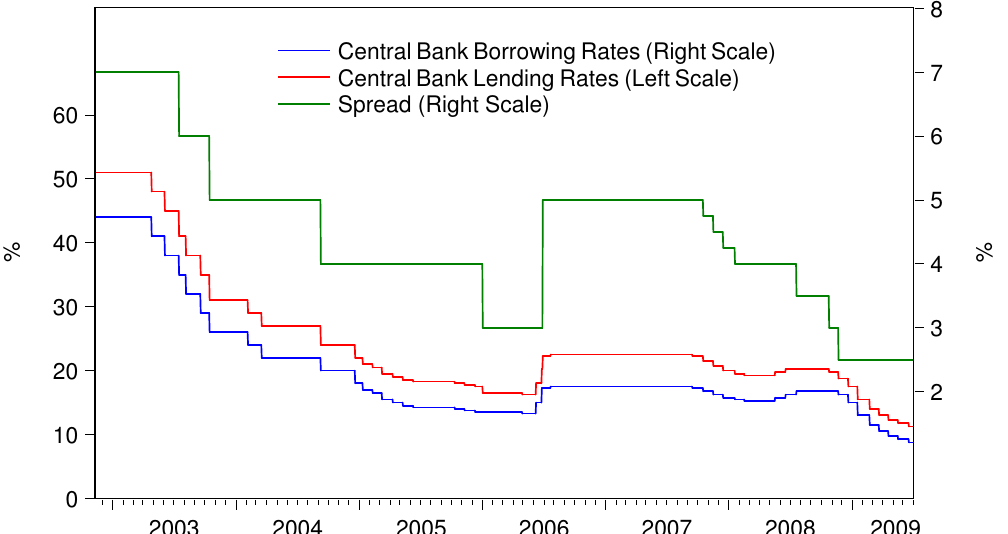
Figure 11. CBRT’s monetary policy